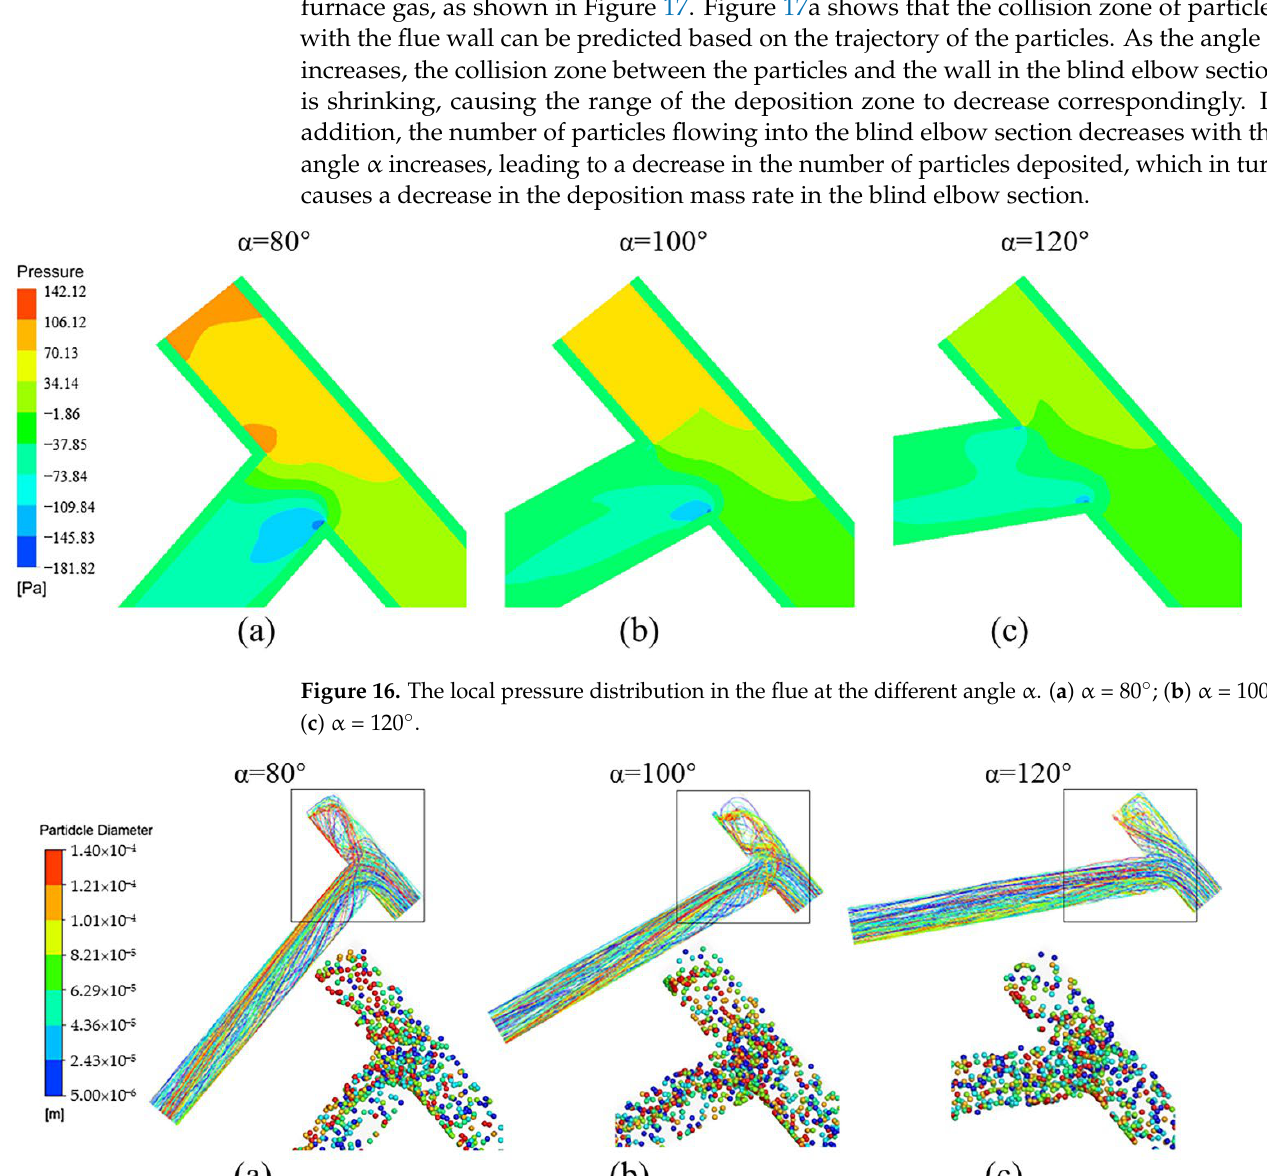
Figure 17. The diagram of particle trajectory at different angle α . ( a ) α = 80 ◦ ; ( b ) α = 100 ◦ ; ( c ) α = 120 ◦